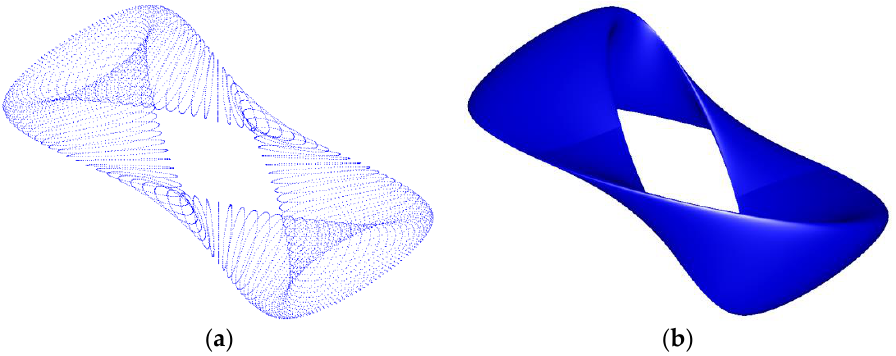
Figure 9. Surface fitting of a posit surface: ( a ) the data chosen randomly from grid data; ( b ) the fitting NURBS surface.